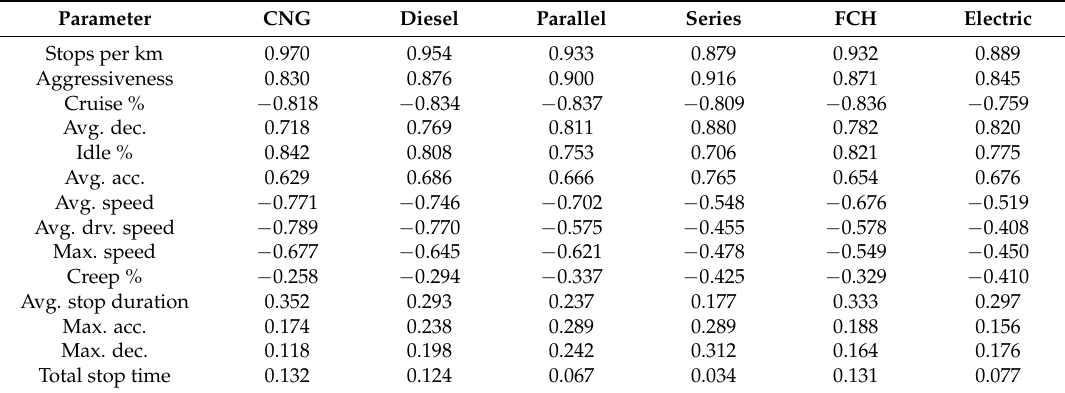
Table 12. Pearson correlation coefficients for cycle parameters and energy consumption on the cycles in Section